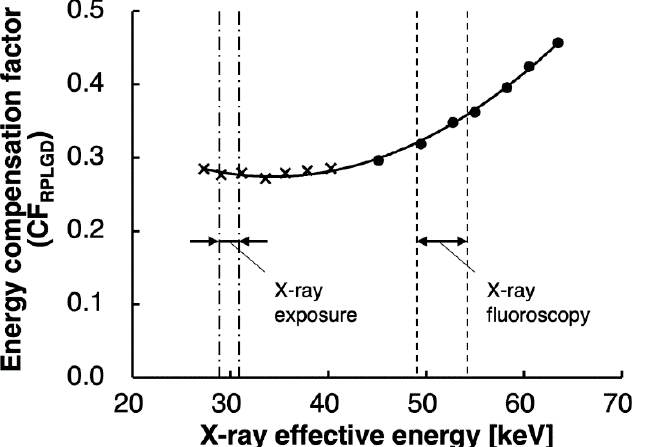
Figure 1. Relationship between X-ray effective energy and the radio-photoluminescence glass dosimeter (RPLGD) energy compensation factor (CF RPLGD ). The symbols ● and × show the data obtained under simultaneous X-ray exposure to the ionization chamber and RPLGDs under settings of fluoroscopy and exposure, respectively. CF RPLGD ( y ) was fitted to the following quadratic equation for X-ray effective energy ( x ): y = 0.0002 x 2 − 0.0147 x + 0.5270 (R = 0.999) (solid line).